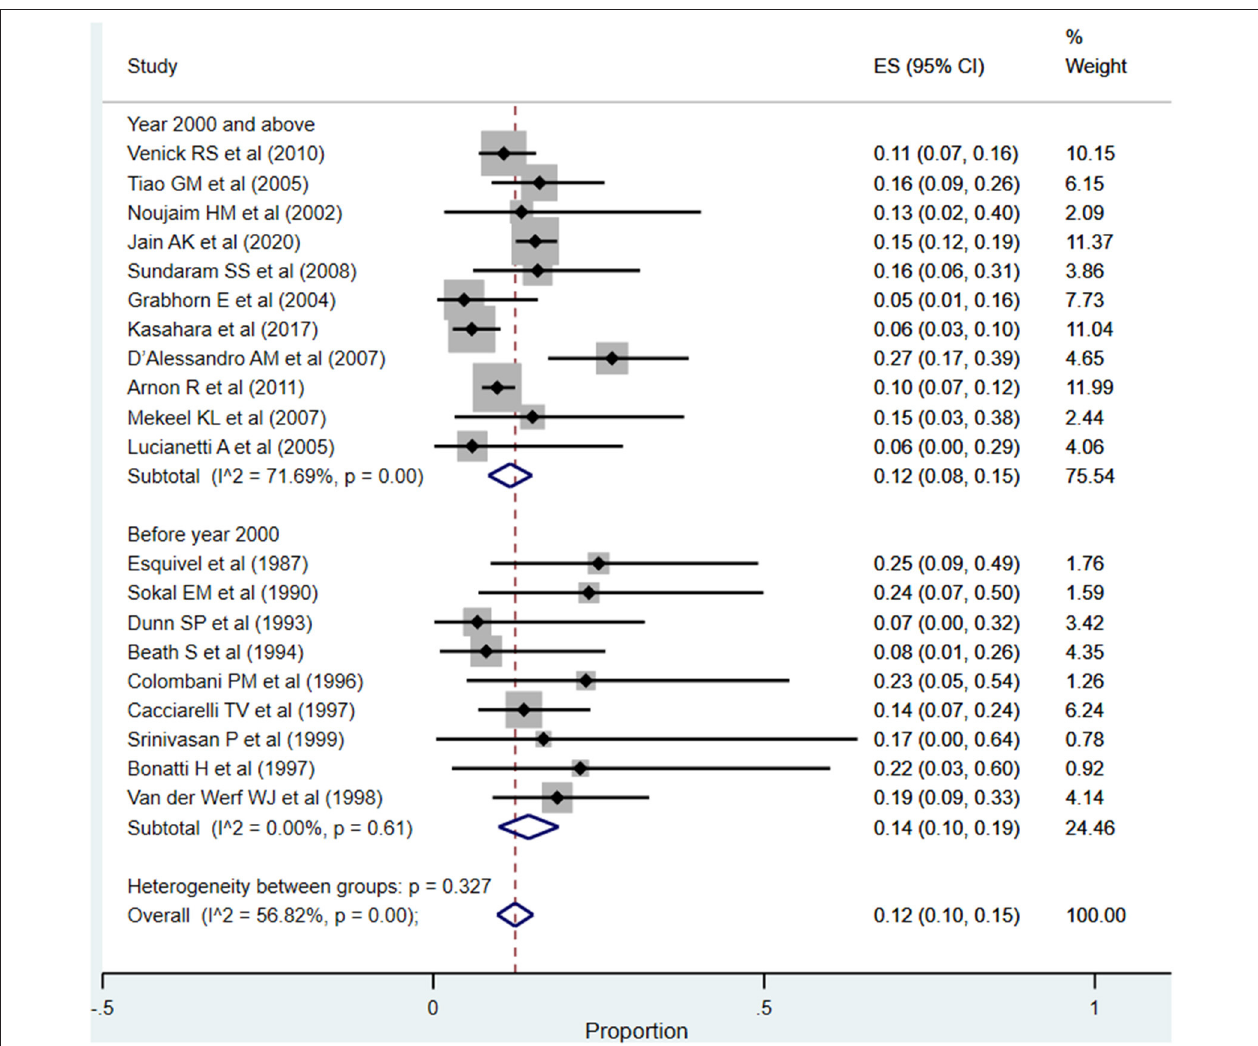
FIGURE 8 | Pooled rate for vascular complications (hepatic artery thrombosis and portal vein thrombosis) in the included studies. ( Table 1 ). Further details of the subgroup analysis have been provided in Table 1